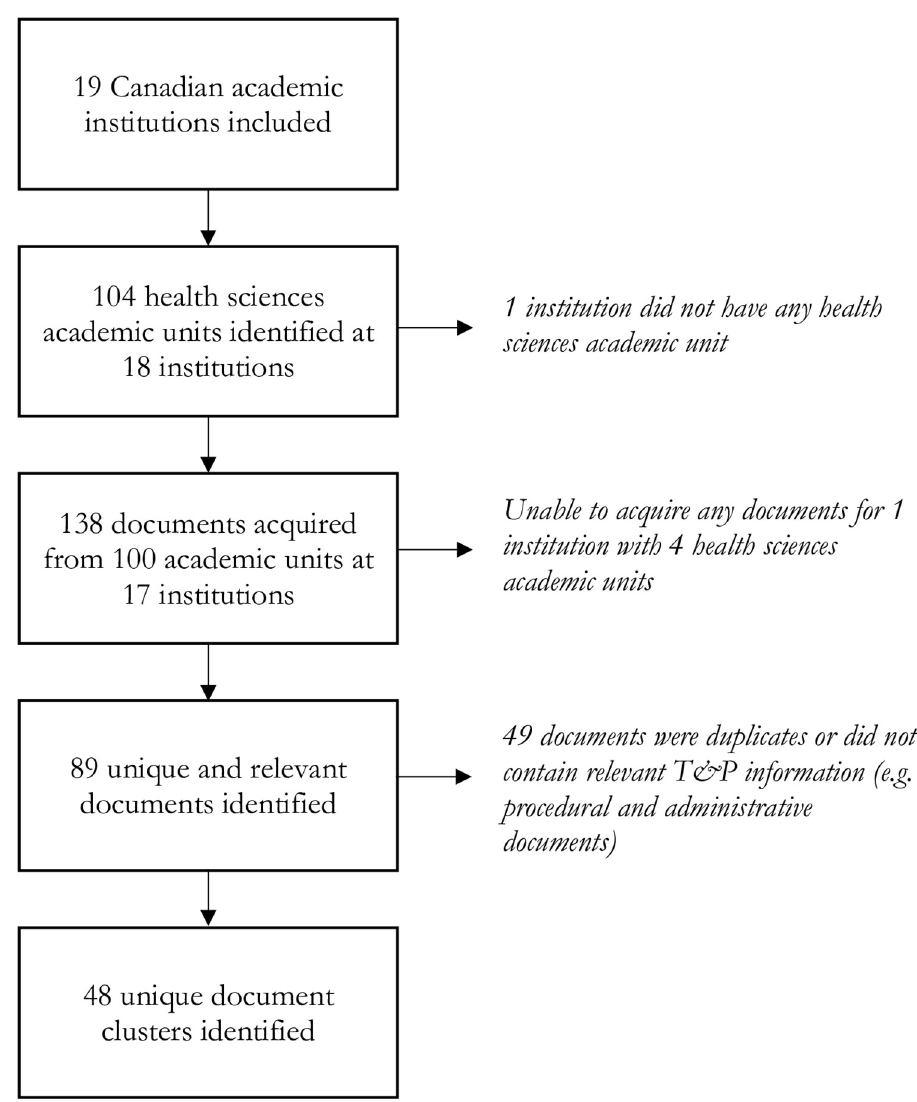
Fig 1. Document search